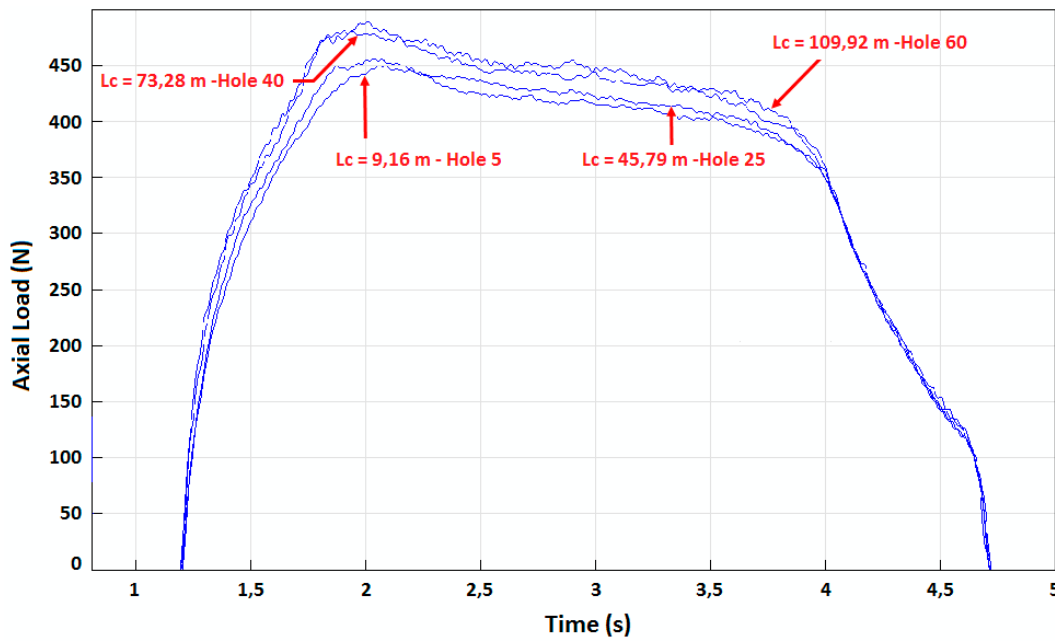
Figure 7. Thrust force versus time in Ti-6%Al-4%V plate alone.